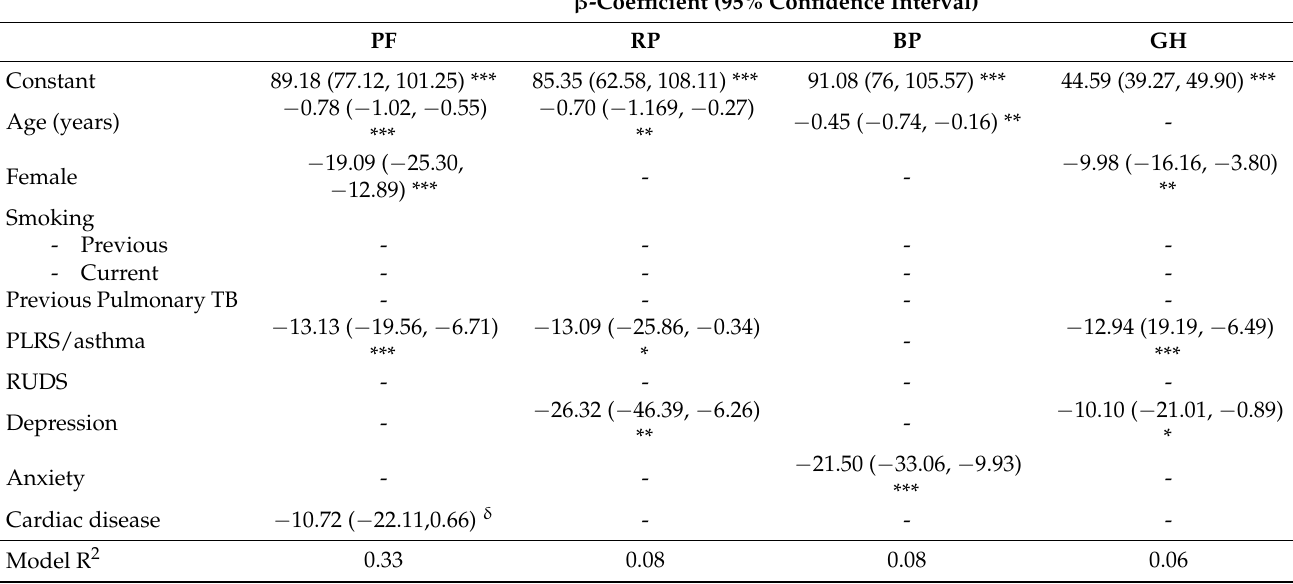
Table 3. Significant determinants of health-related quality of life according to SF-36 subscale scores for physical health domains of Macassar residents ( n = 246) 6 years after the fire incident using multivariate linear regression